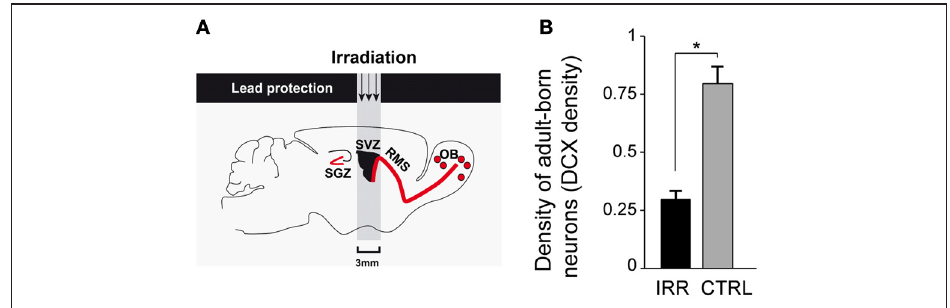
FIGURE 2 | Disruption of adult olfactory neurogenesis. (A) Gamma irradiation was targeted to the SVZ, protecting the rest of the brain with a lead shield (for details see Lazarini et al., 2009; Feierstein et al., 2010). The SGZ, the site of hippocampal neurogenesis, was not affected. (B) Adult neurogenesis was reduced in the OB of irradiated (IRR) compared to control (CTRL) females. Density of adult-born neurons is measured as the density of DCX + (a marker expressed in immature neurons) cells in the OB 6.5 months after irradiation. * p < 0 . 01. OB, olfactory bulb; SVZ, subventricular zone; RMS, rostral migratory stream; SGZ, subgranular zone. Modified from Feierstein et al.